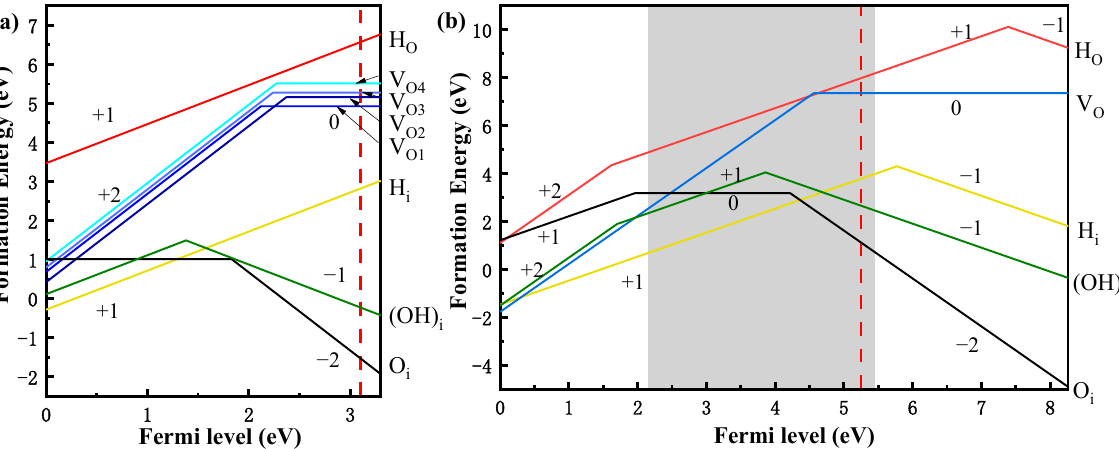
Figure 3. The formation energy of defects under O-rich condition for CAAC-IGZO ( a ) and Al 2 O 3 ( b ). The red dotted line represents the Fermi level in the absence of an electric field and the grey area in ( b ) represents the area of band gap in CAAC-IGZO.